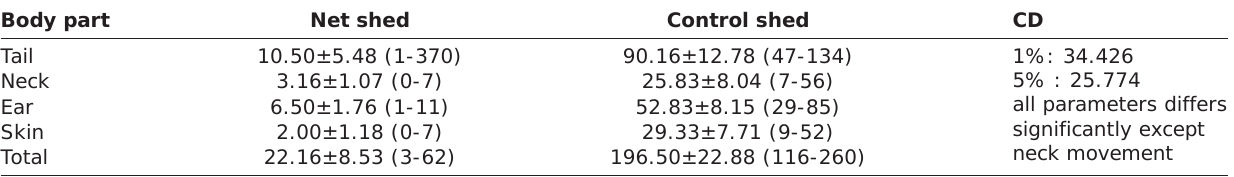
Table-7: Body movements within 10 min time in net and control shed.